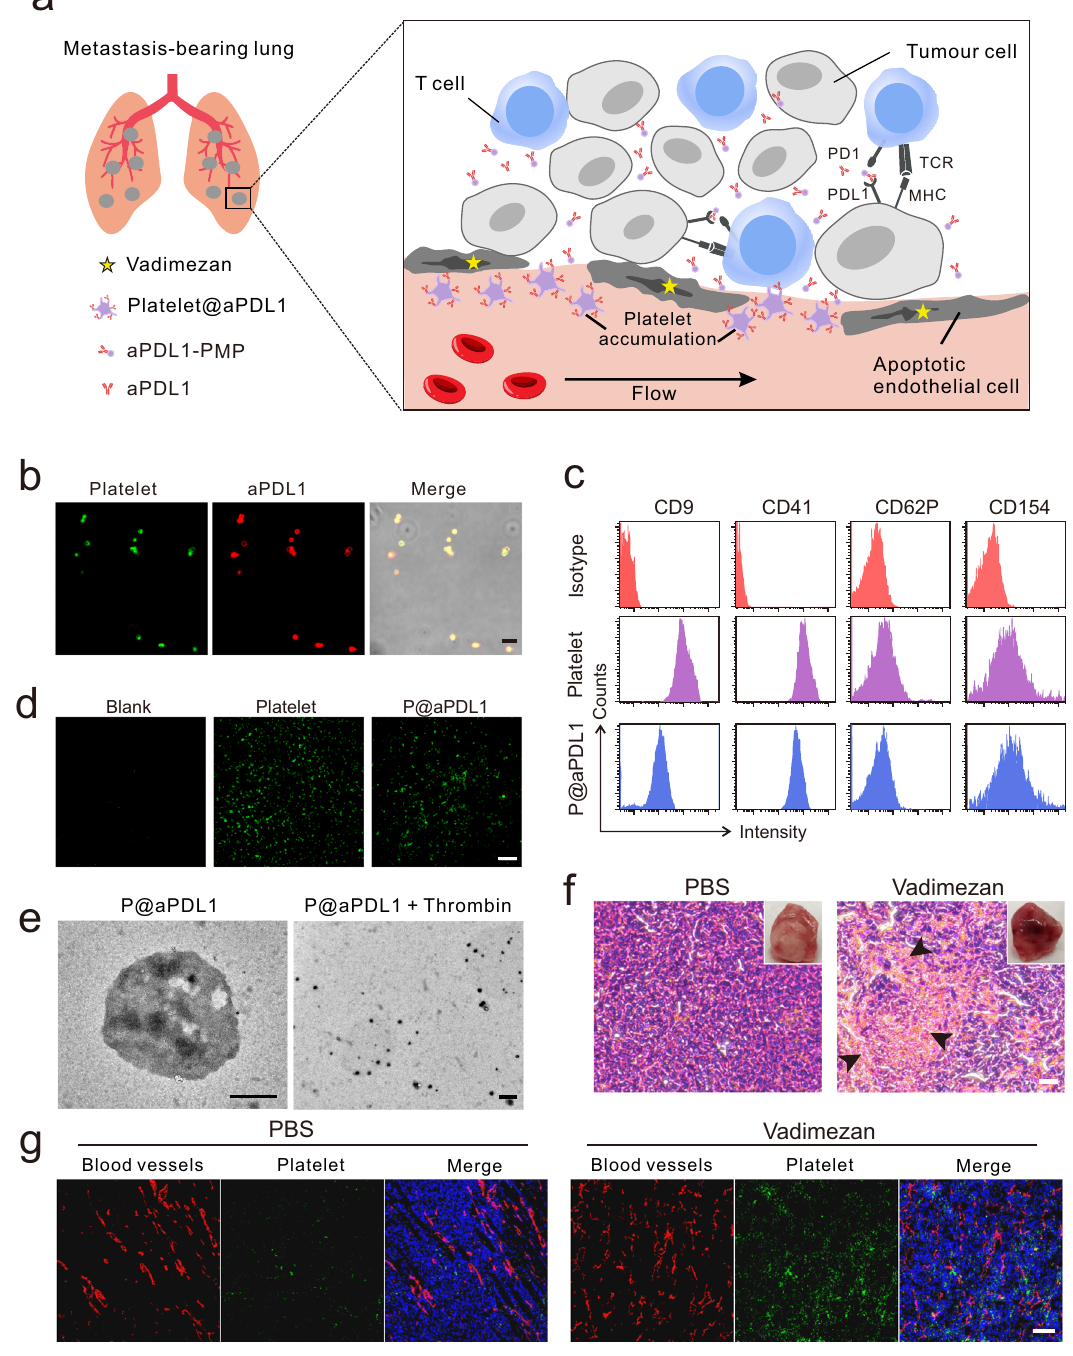
Fig. 1 Characterisation of aPDL1-conjugated platelets and disruption of tumour blood vessel caused by Vadimezan. a Schematic of using aPDL1- engineered platelets combined with Vadimezan to treat tumour metastases. b Confocal images of aPDL1-conjugated platelets (P@aPDL1). Platelets were labelled with WGA-488 (green) and the aPDL1 was tracked by Cy5-conjugated anti-rat IgG antibody (red), scale bar: 5 μ m. c Flow cytometry analysis of the proteins on the native platelets and P@aPDL1. CD154 and CD62P were measured after the activation of the platelet. d Collagen-binding ability of native platelet and P@aPDL1. The blank was not pretreated with collagen, scale bar: 200 μ m. e TEM image of the P@aPDL1 and platelet-derived microparticles (PMPs) generated by stimulation of P@aPDL1 with thrombin, scale bar: 500 nm. f The photograph and H&E staining image of the 4T1 tumour post- treatment with PBS and Vadimezan. Black arrows marked the haemorrhaging sites in the tumour, scale bar: 20 µ m. g Confocal images of the blood vessels and activated platelets in the 4T1 tumours treated with Vadimezan. Blood vessels were marked with an anti-CD31 antibody (red), the activated platelets were labelled with anti-CD62P antibody (green), and the nucleus were stained with Hoechst 33342 (blue), scale bar: 100 µ